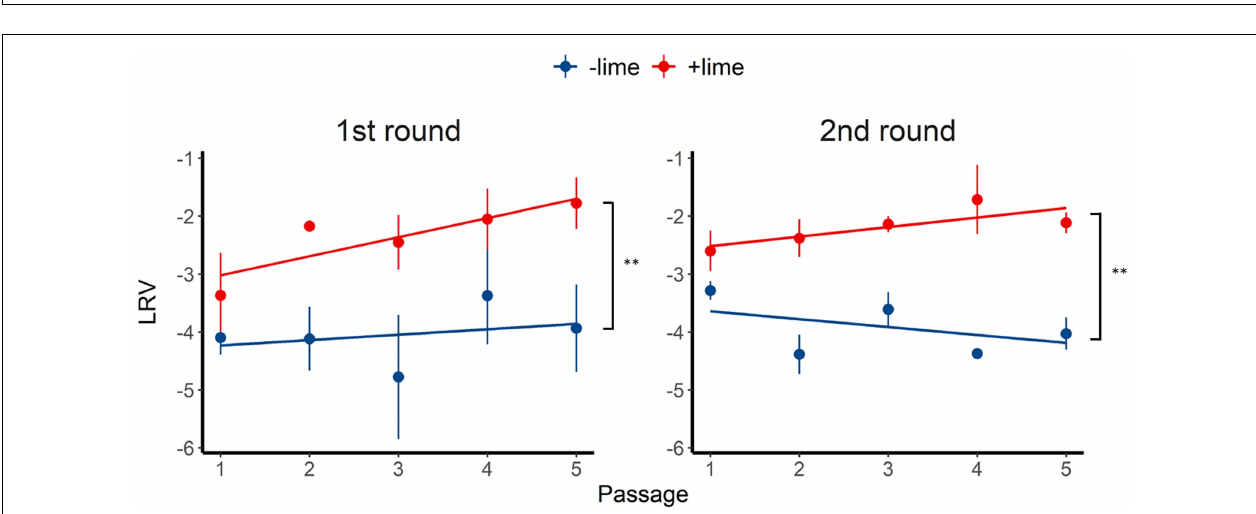
FIGURE 2 | Time-series inactivation rate of murine norovirus obtained in serial passages without (blue) and with (red) lime treatment in the first (A) and second (B) rounds. Each point represents an average value from three replicates.